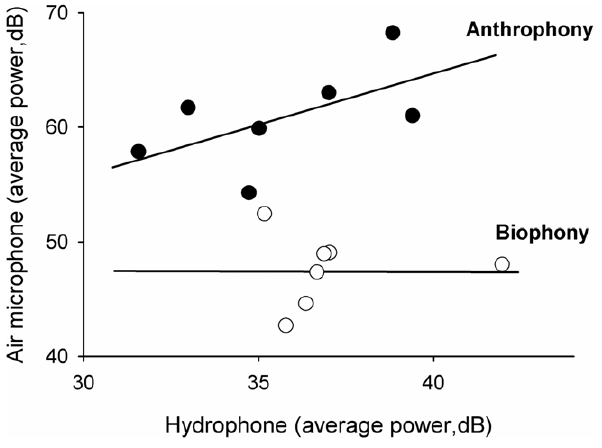
Figure 3. Relationship of above- and below-water sound. Patterns and correlation of overall sound (average power in dB) N between above-water and hydrophone data by frequencies corre- , mean: 1–3 kHz) and biophony ( O , mean: sponding to anthrophony ( 3–8 kHz). Regression on individual frequency intervals resulted in a significant correlation for only the 0–1 kHz band ( R 2 =0.71, p =0.02, all others R 2 , 0.03, p . 0.69).